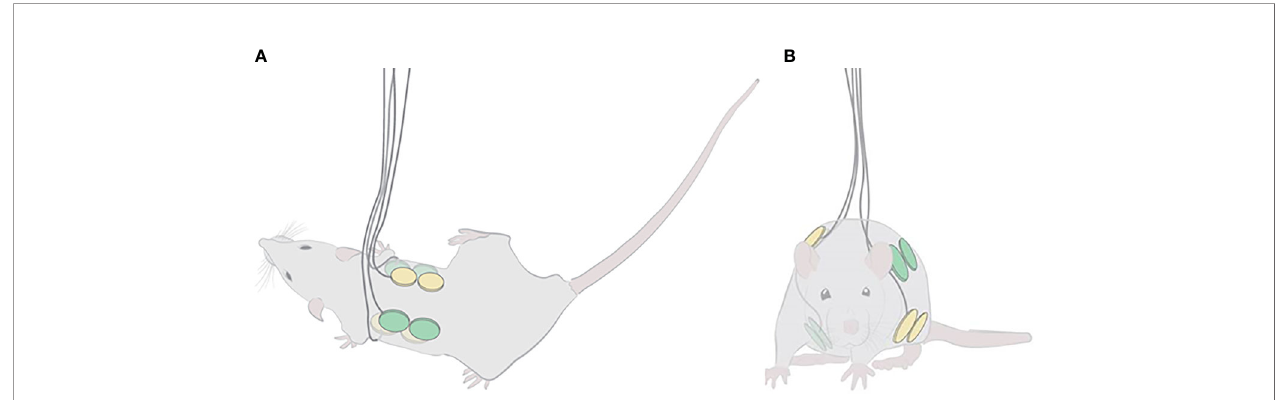
FIGURE 1 | Localization of TTFields and sham arrays on the torso of rats. Illustrations of the positioning of the 2 array pairs, one shown in yellow and the other in green, on the depilated rat torso: (A) top view, depicting the anteroposterior positioning of the 2 ceramic discs of each dorsal array (ventral arrays may be seen transparently in the background); and (B) front view, demonstrating the orthogonality of the 2 array